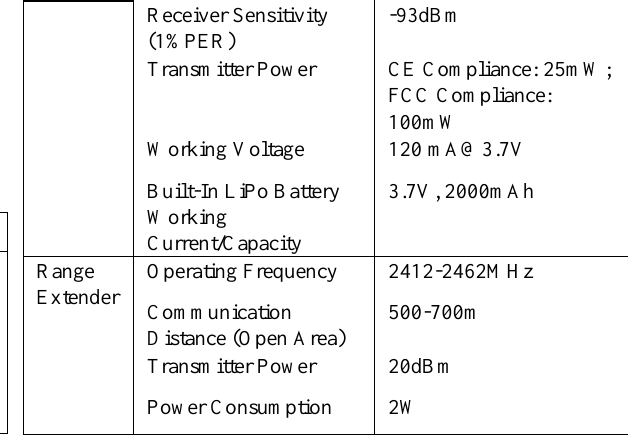
Table 1. Leica Ts-02 Specifications Table 2. DJI Phantom 2 vision plus specifications